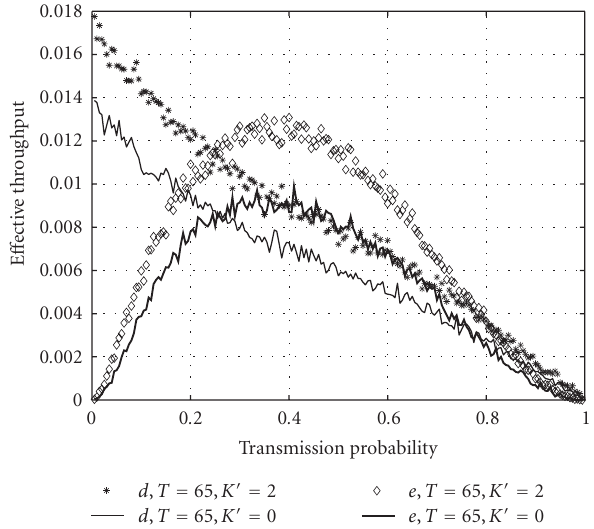
Figure 26: The e ff ective throughput of the dynamic ( K (cid:5) = 2) and the static ( K (cid:5) = 0) cases for K = 4 and T = 65 (connections d and e of the asymmetric network of Figure